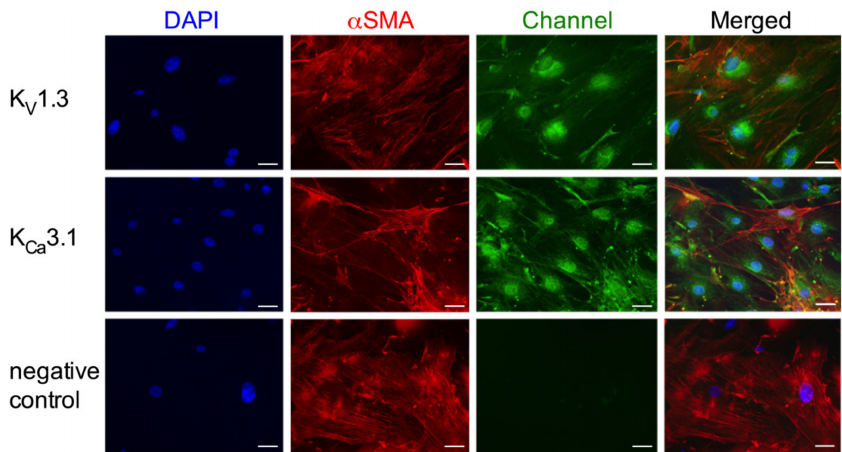
Figure 6. Immunocytological analyses on K V 1.3 and K Ca 3.1 localization in mouse primary artery SMCs. Cells were stained with antibodies against the K V 1.3 (upper panels, green) or the K Ca 3.1 channel (middle panels, green) together with an antibody against the SMC marker α SM-actin (red) and counterstained with DAPI (blue) to show the nuclei. For negative control (lower panels) the primary antibody was omitted. Scale bar 40 µ m.